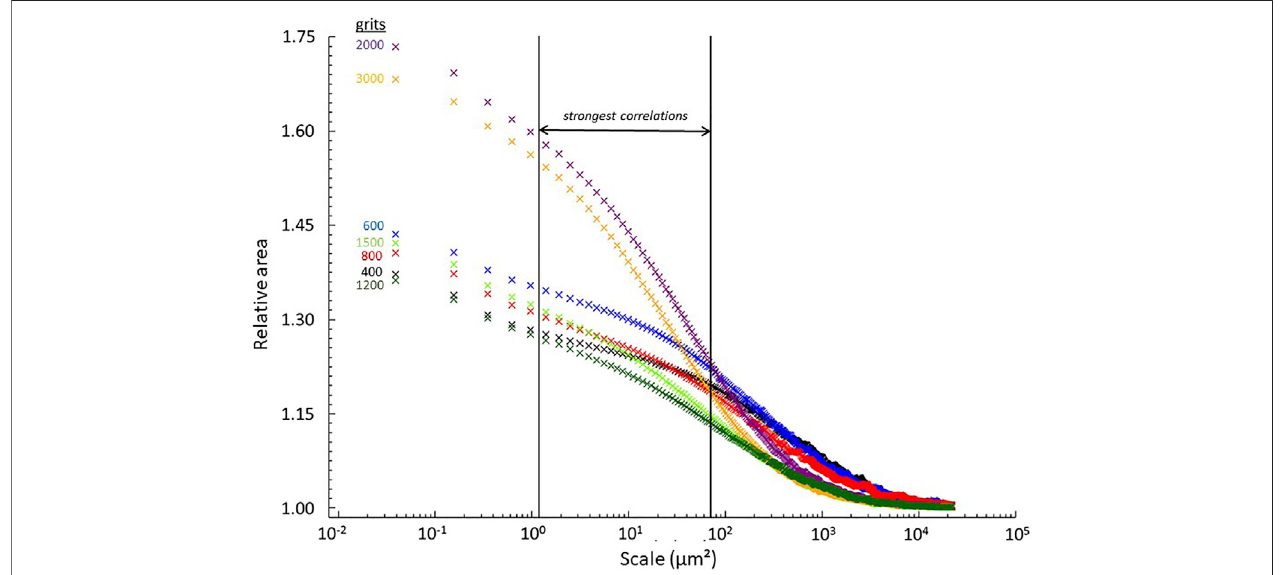
FIGURE 1 | Relative area versus scale. Grit sizes are noted on the fi gure along with the scale range for the strongest correlations of advancing contact angles regressed versus area-scale complexities.